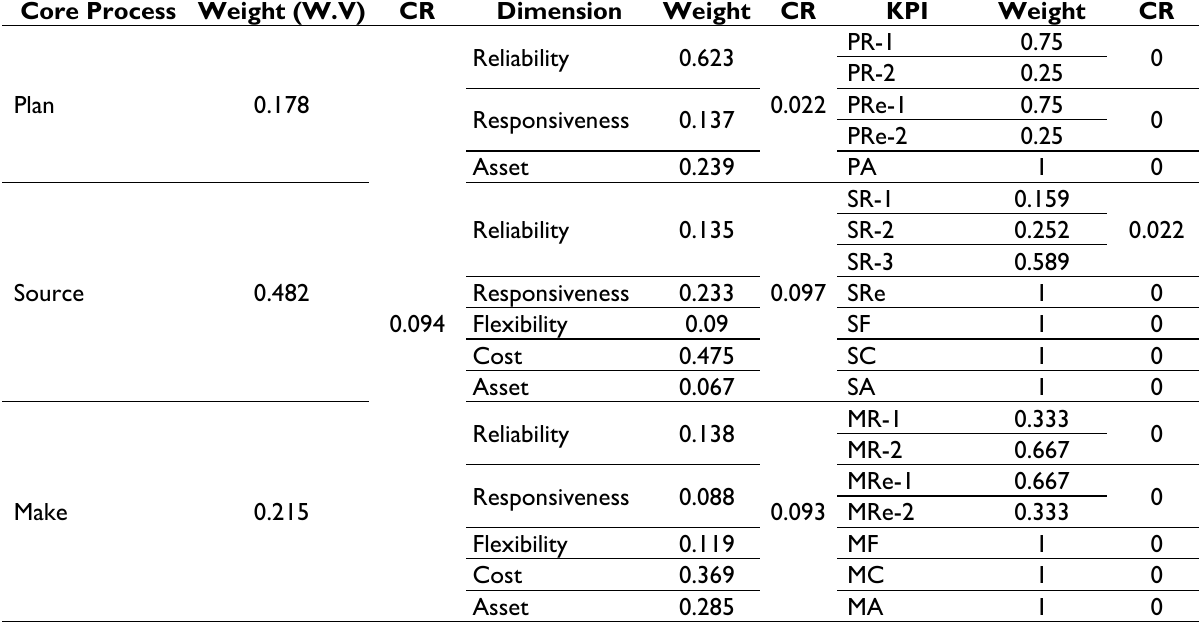
Tabel 10: Weight Value of Each Level Core Process Weight